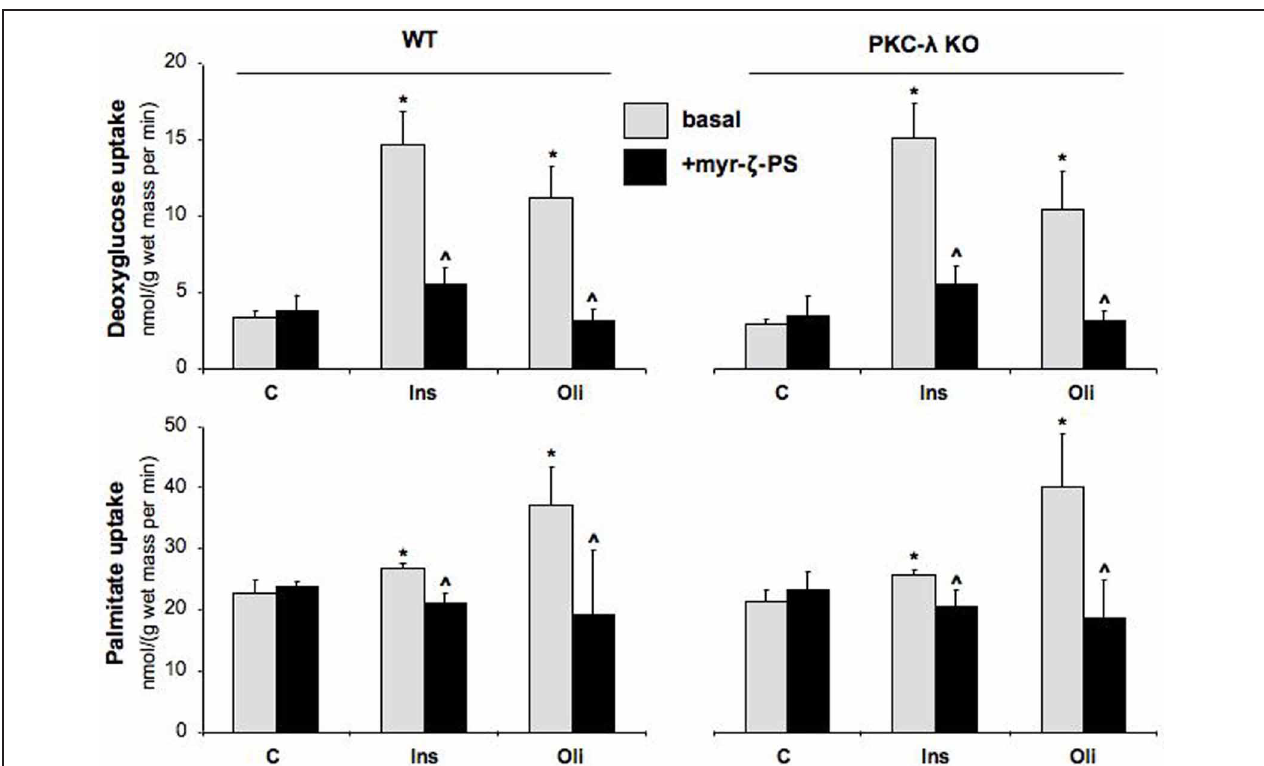
the absence (Ctrl) or presence of 100nM insulin (Ins) or 1 μ M oligomycin (Oli), whereafter uptake rates of 3 H-deoxyglucose and 14 C-palmitate were measured. Data are means ± SEM for six experiments carried out with different cardiomyocyte preparations. ∗ Significantly different from Ctrl ( P < 0 . 05). ∧ Significantly different from corresponding basal ( P < 0 .